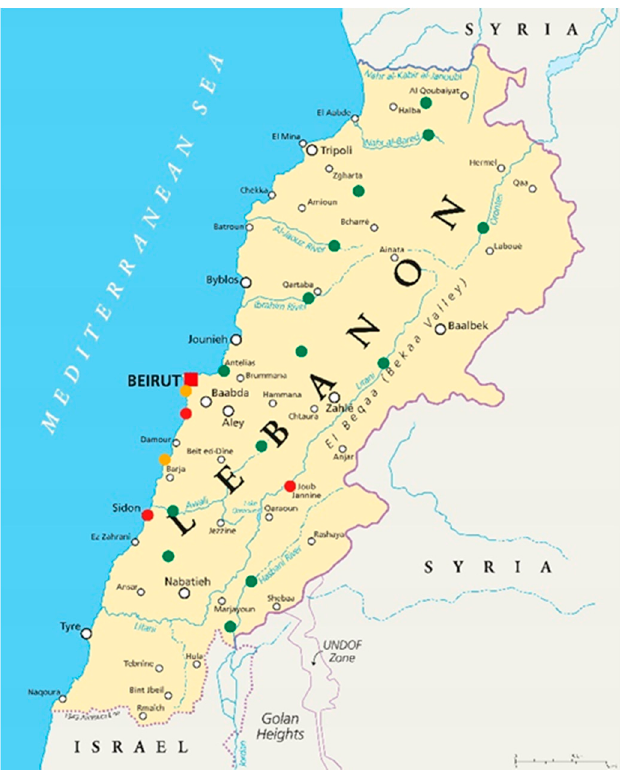
Figure 1. Map of Lebanon with the sample collection sites (green: rivers; red: WWTPs; orange: sewage outfalls).